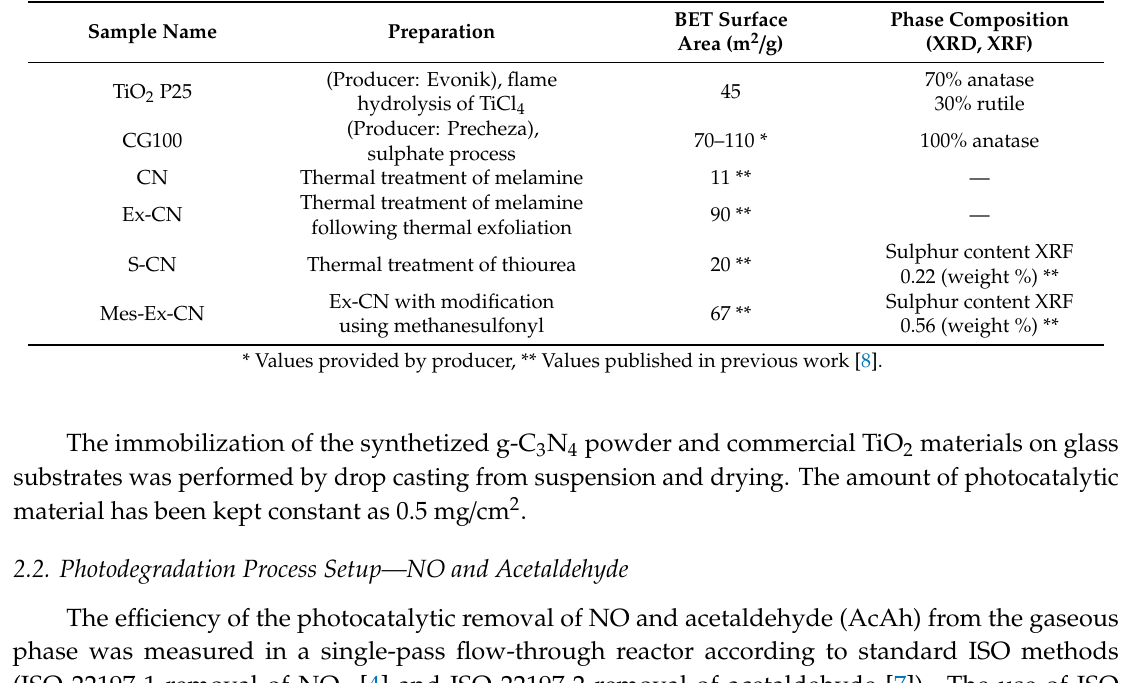
Table 1. Summary and properties of studied photocatalytic materials.